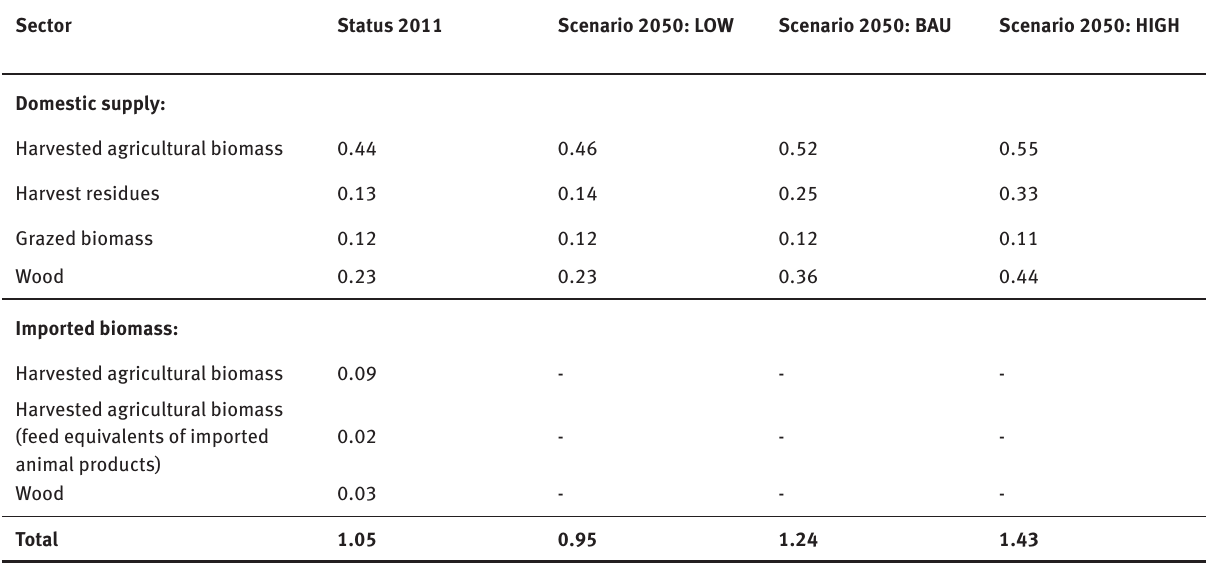
Table 3: Biomass supply of the EU-27 in 2011 and 2050 in different scenarios, in billion tonnes dry matter (based on Piotrowski et al. 2015)